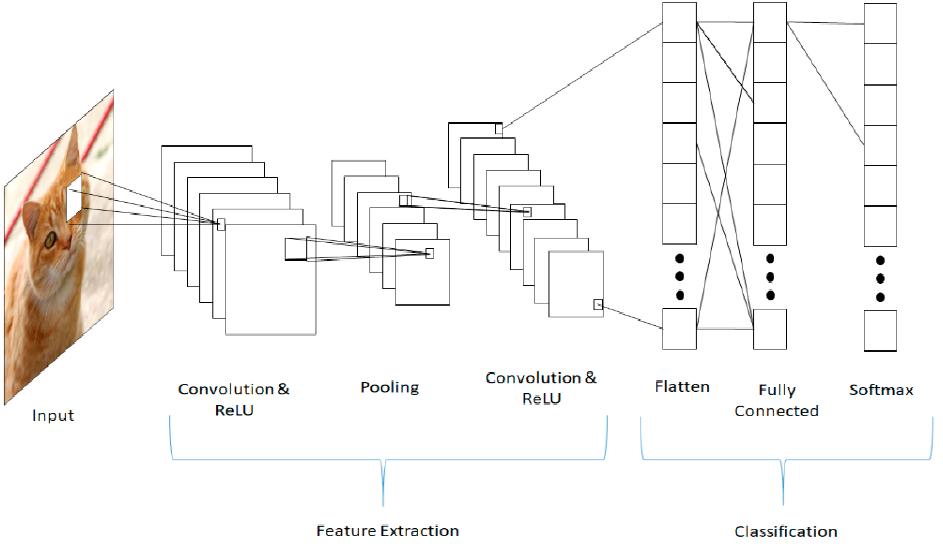
Figure 8. Convolutional neural network